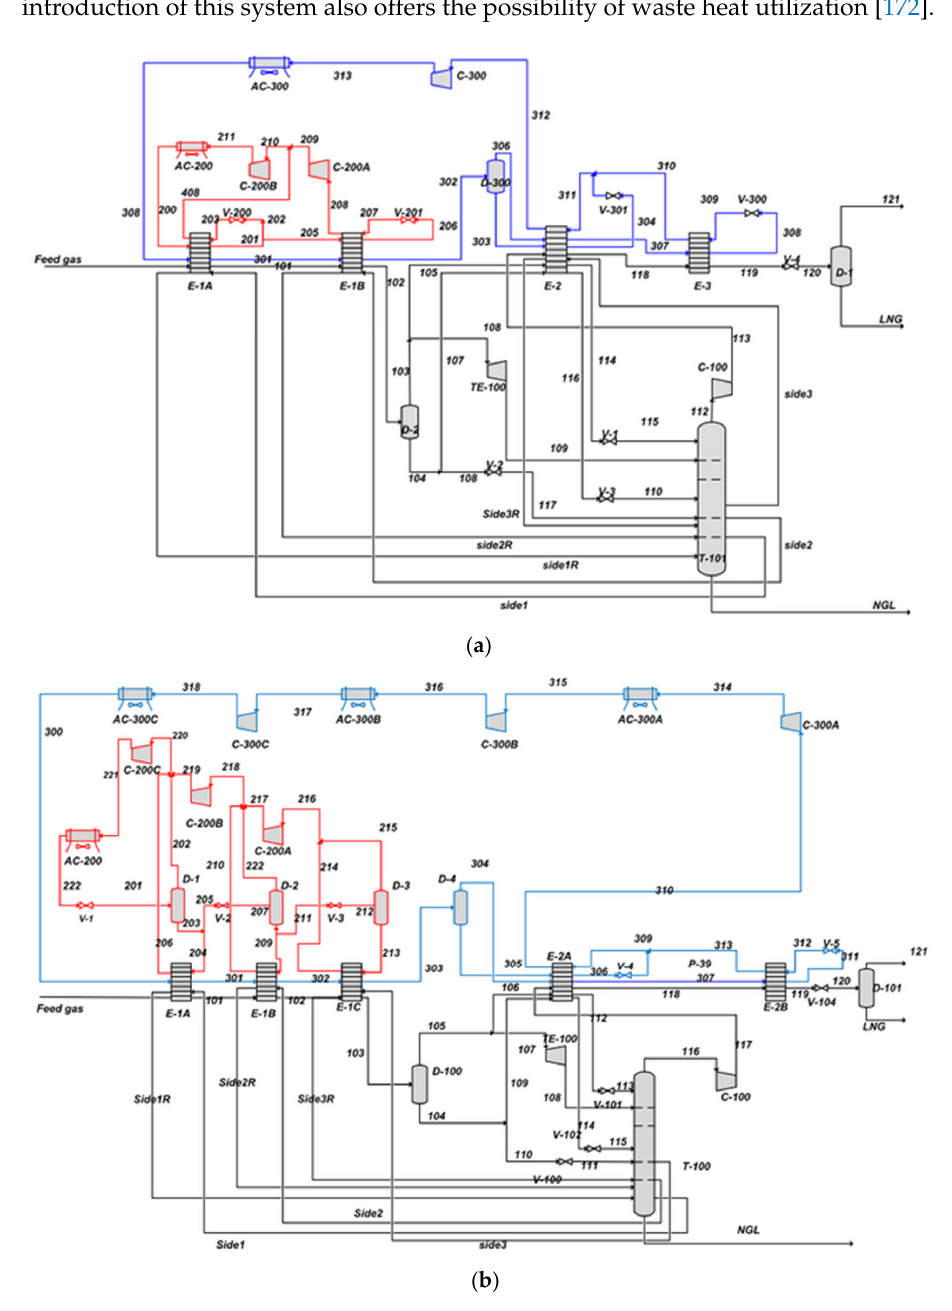
Figure 43. Process flow diagram for co-production of LNG and NGL: ( a ) Process flow diagram of the DMR configuration; ( b ) Process flow diagram of the C3-MR process [48]. Reprinted